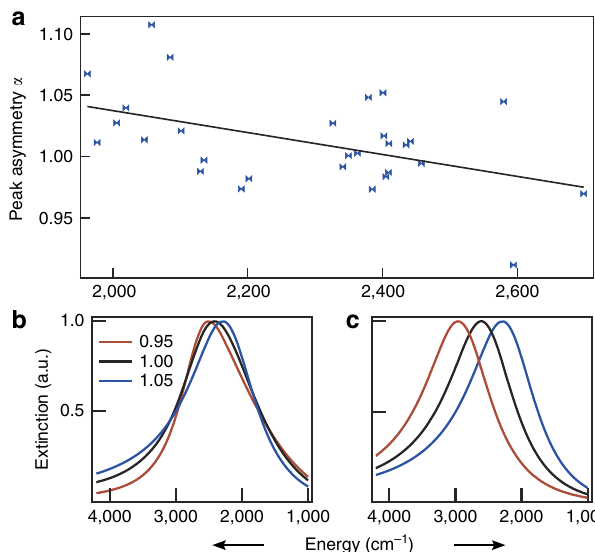
Figure 3 | Sources of heterogeneity in single nanocrystal LSPR spectra. ( a ) Experimental observation of correlation between peak energy and peak asymmetry. ( b ) Simulations of peak shapes resulting from variations in the strength of frequency-dependent damping can account for heterogeneity in peak asymmetry. The a value of each peak is shown. ( c ) Simulated spectra over a range of electron concentrations account for variations in peak energy.